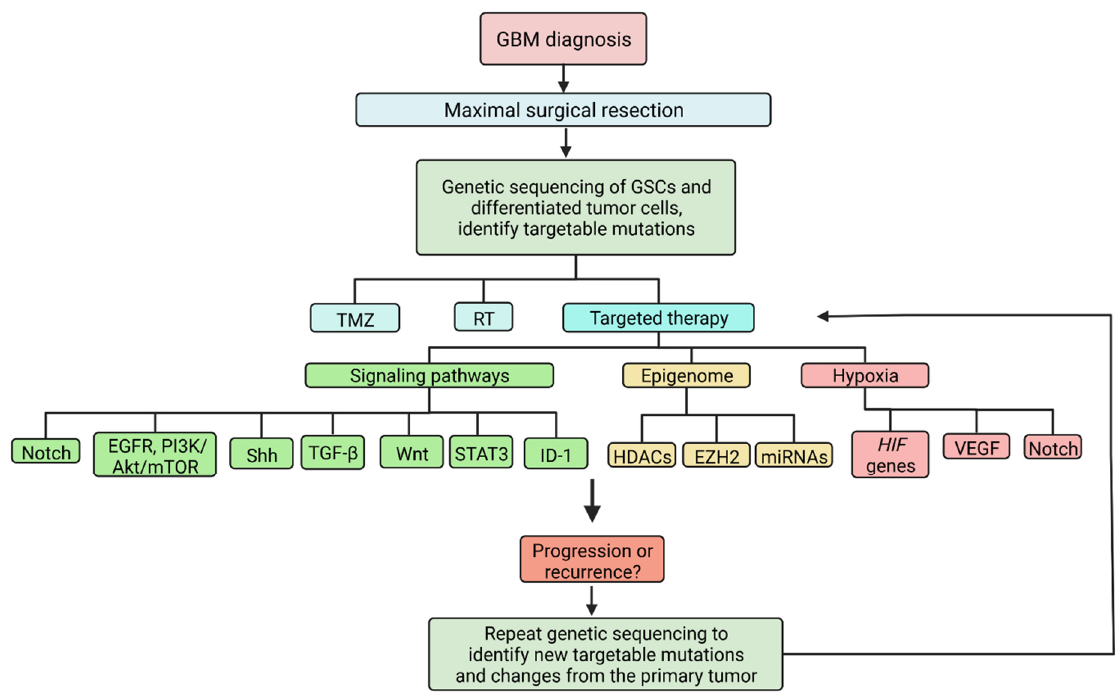
Figure 3. Proposed future management algorithm for GBM. The genomic revolution has offered significant insights into pathogenesis of GBM and resistance to TMZ and RT. Clinicians may eventually have an array of pharmaceutical agents and therapeutics designed to target specific molecular components of tumor cells and GSCs. Following maximal surgical resection, genomic analysis should be performed to identify key signaling pathways and genomic mutations in GSCs that can allow for personalized targeted therapy, performed alongside adjuvant TMZ and RT. Clinicians may eventually select from amongst several drugs those likely to exert the most profound anti-GBM effect based on the genomic analysis. In the case of tumor progression or recurrence, repeat sequencing can be performed to identify new actionable mutations for targeted therapy. Additionally, the targeted therapy may sensitize the tumors to TMZ and RT, and synergistic effects may arise from multiple regimens. Addi- tional therapeutic agents can also be designed to target differentiated tumor cells. EGFR—epidermal growth factor receptor, EZH2—Enhancer of zeste homolog 2, GBM—glioblastoma, HDAC—histone